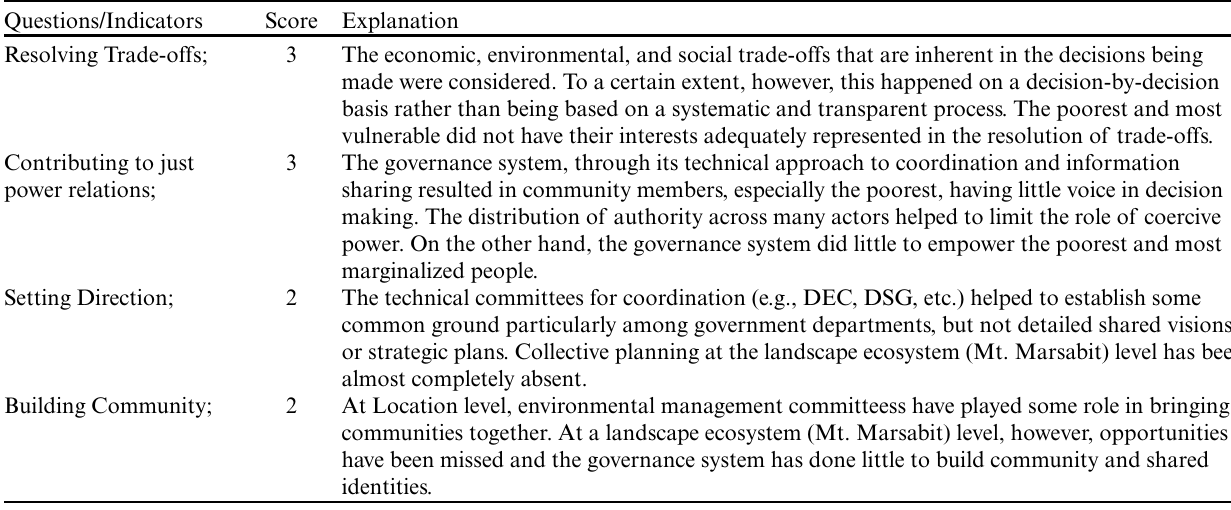
Table 3 . Assessment of governance outcomes. (DEC = District Environment Committee; DSG = District Steering Group).